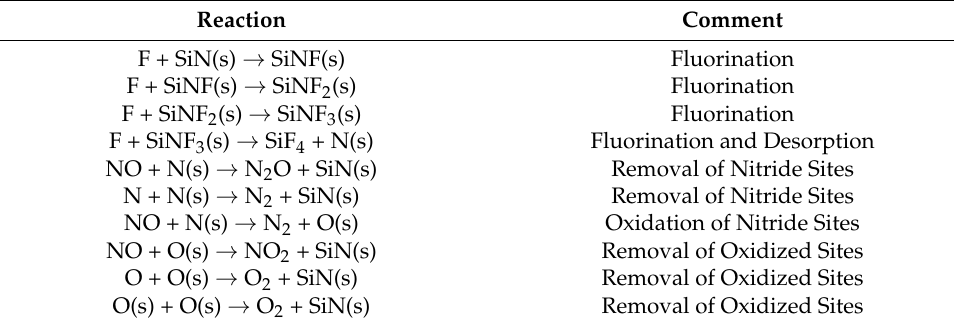
Table 5. Surface reaction mechanism in Si 3 N 4